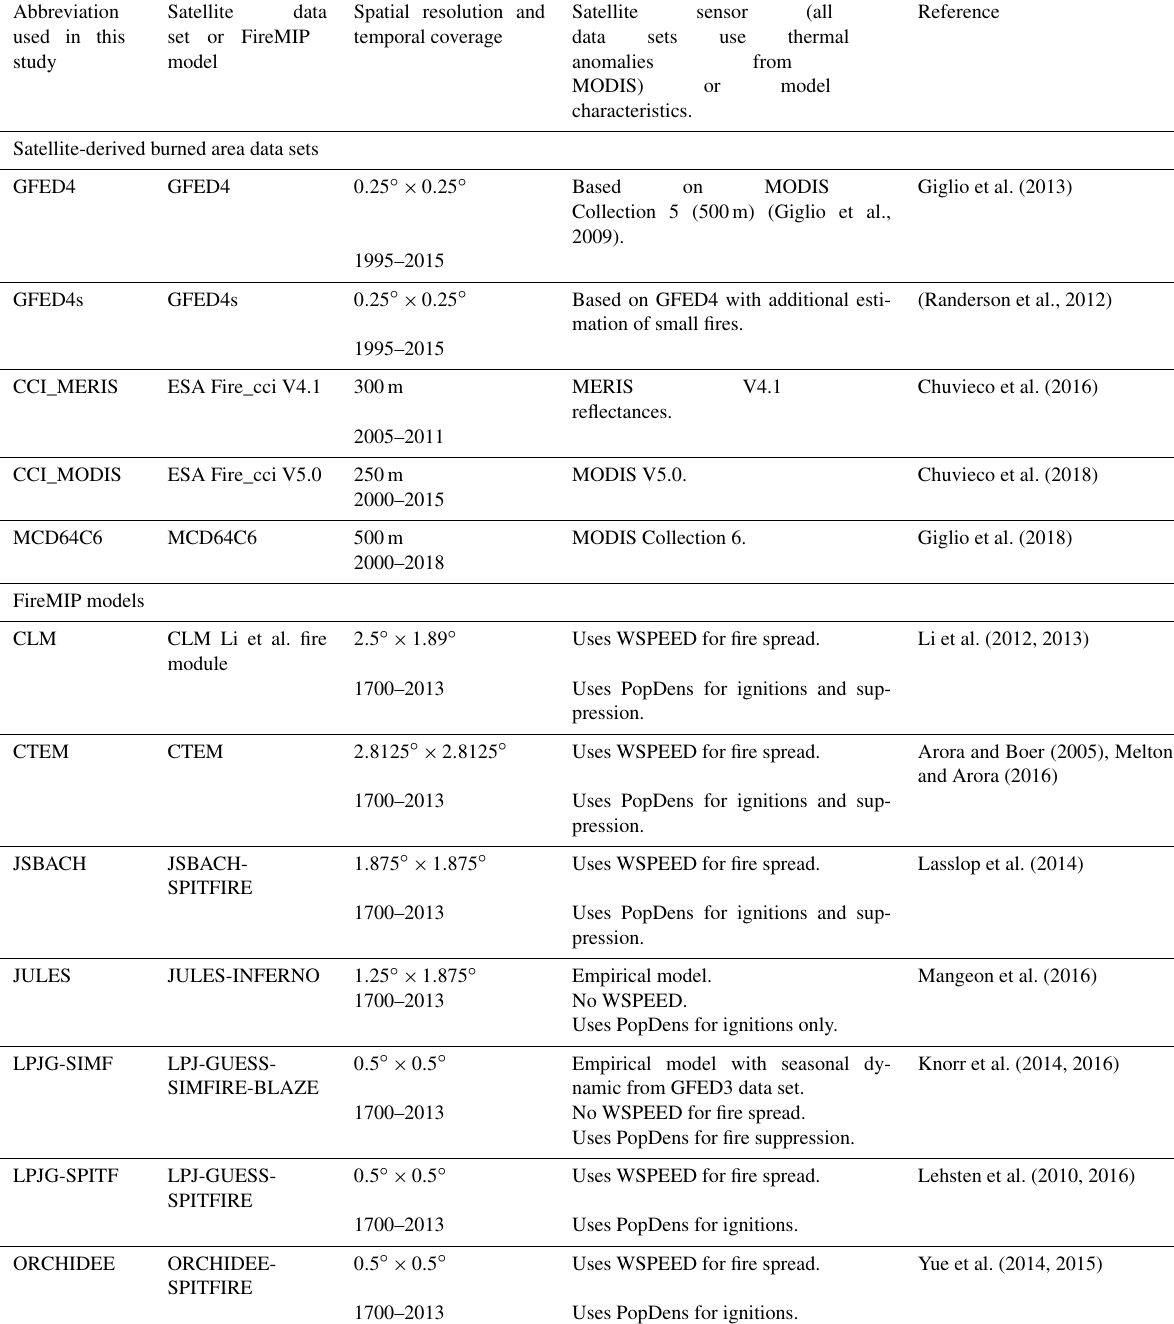
Table 1. Overview of used burned area data sets and FireMIP